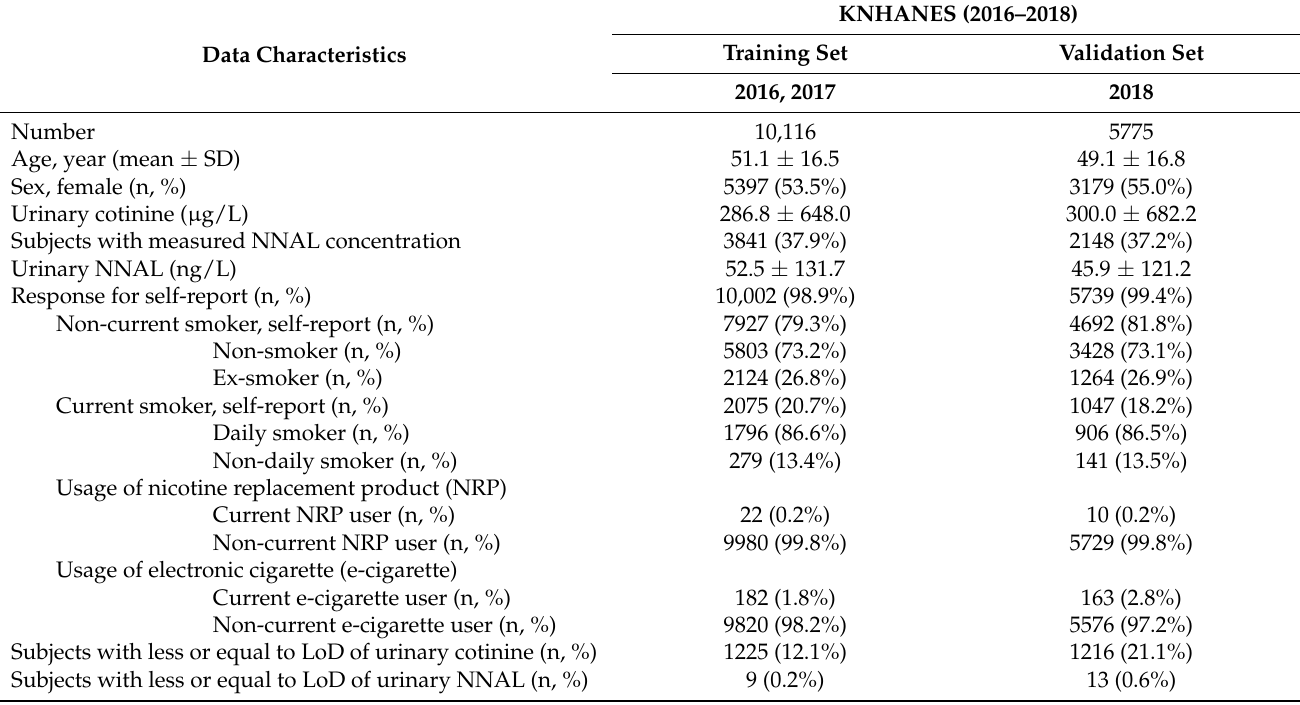
Table 1. Characteristics of the study